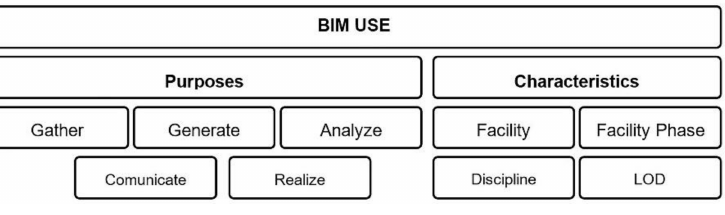
Figure 5. The components of a BIM use, adapted from ref. [29].